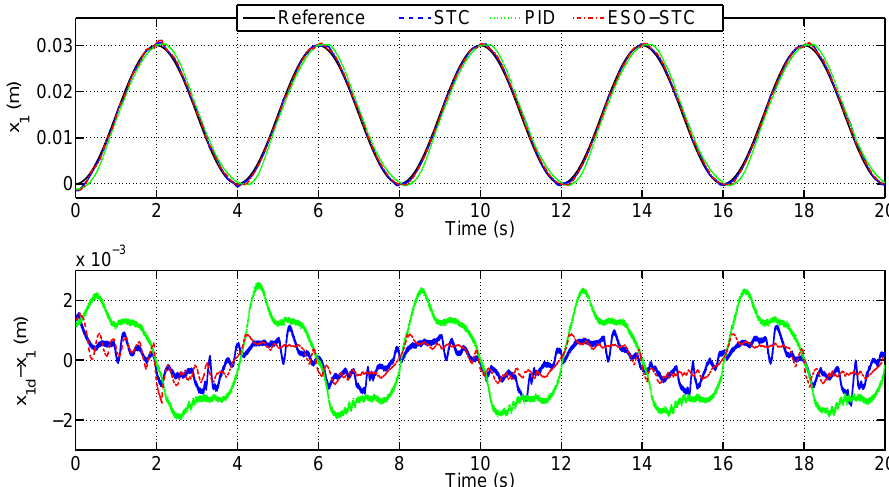
Figure 4. The comparisons of different control